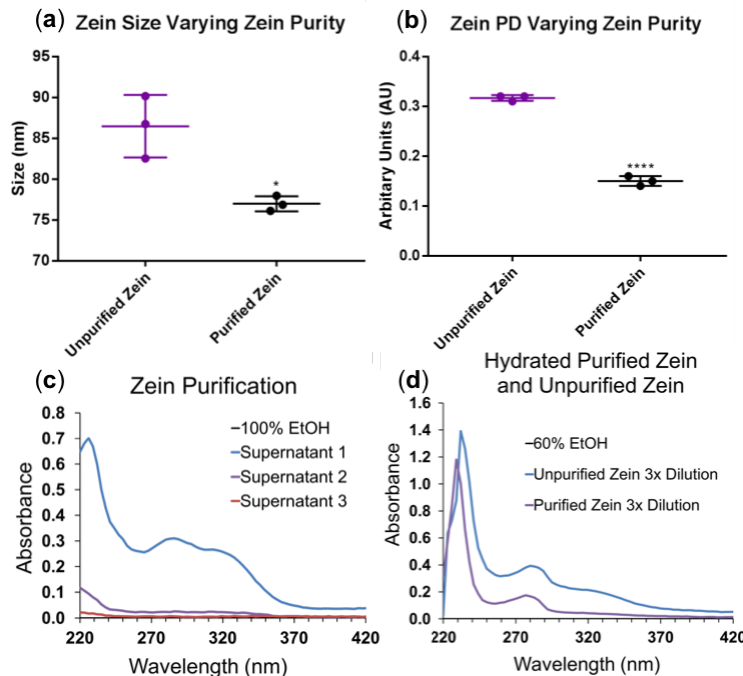
Figure A4. ( a ) The diameter of Zein nanoparticles ’ (NPs’) varying purities; ( b ) The polydispersity (PD) of Zein NPs’ varying purity; ( c ) the Ultraviolet-Visible Spectroscopy (UV-Vis) of each of the supernatants used to purify the Zein; ( d ) UV-Vis of a 3x dilution 1% unpurified Zein stock relative to a 3x dilution 1% purified Zein stock.